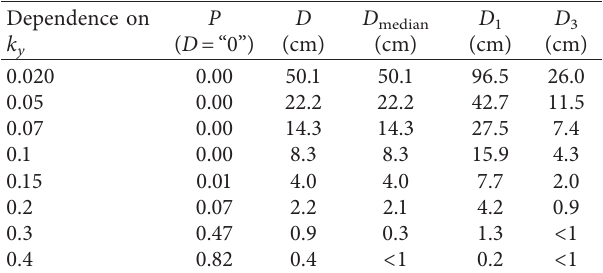
Table 3: Bray and Travasarou dependence on k